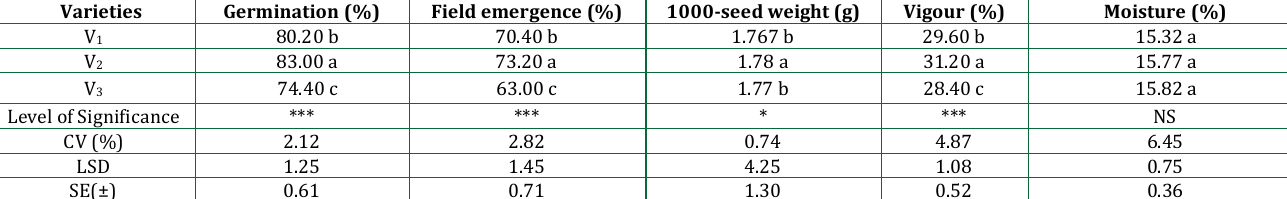
Table 2: Effect of storage periods on seed qualities of tossa ( Corchorus olitorius L.) jute varieties. Varieties